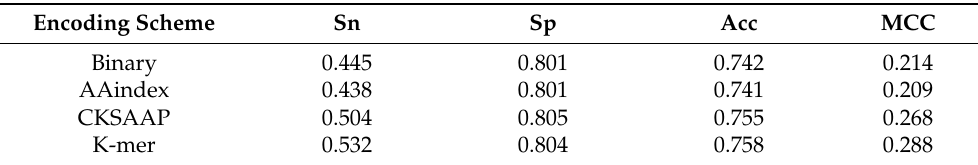
Table 4. Prediction performance of the single encoding-employing models with feature selection on the independent